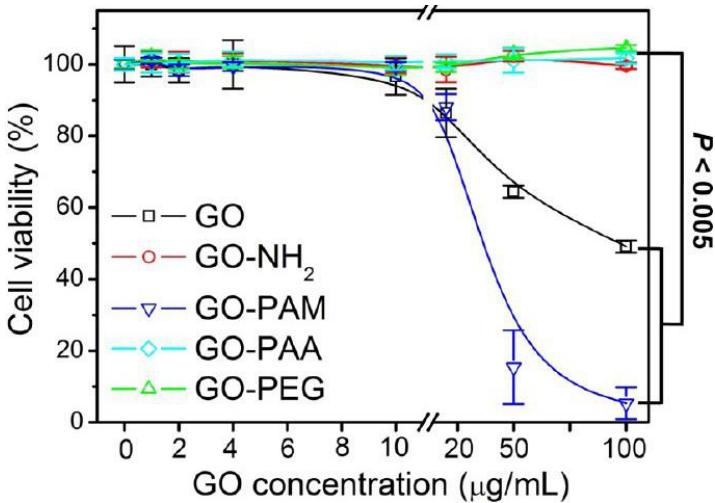
Figure 15. CCK-8 assay results of macrophage cells (J774A.1) treated with GO, GO-NH 2 , poly(acrylamide)-functionalized GO (GO-PAM), poly(acrylic acid)-functionalized GO (GO-PAA), and poly(acrylamide)-polyethylene glycol (GO-PEG) at different concentrations for 24 h ( n = 5). Reproduced from [119] with permission from The American Chemical Society.